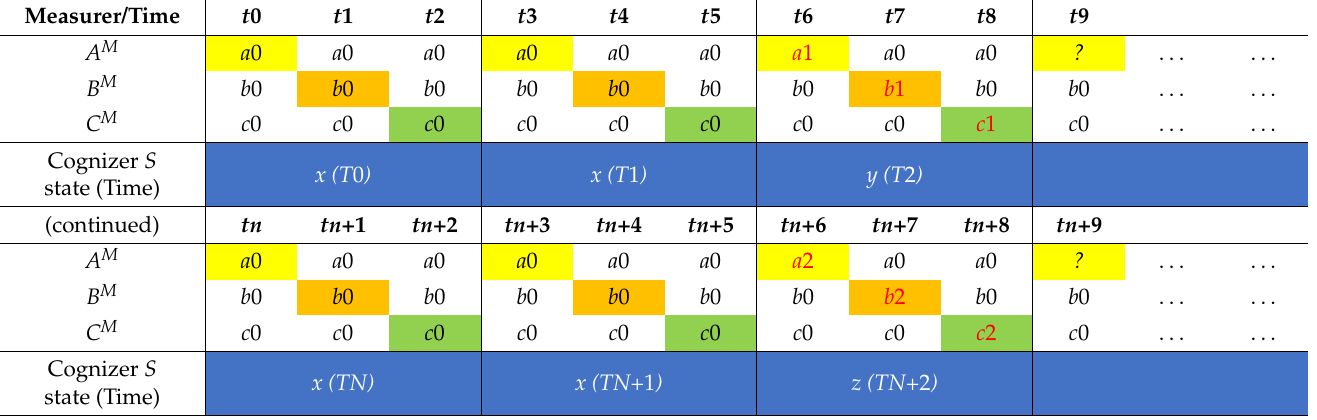
Table 3. A focal cognizer S is composed of three measurer cognizers, A M , B M , and C M , representing a sensor, a signal transducer, and a hypothetical apparatus of the IC operation on the whole sequence (ICW) of a living system, respectively. In addition, a 0, b 1 - 0, and b 2 - 0 are the baseline states of the measurers A M , B M 1, and B M 2. One-to-many changes are highlighted with red symbols. The measurers change their states on a fine-grained timescale, t0, t1, t3, . . . , tn, tn+1, tn+2. The cognizer changes its states on a coarse-grained timescale, T0, T1, . . . , T N , T N